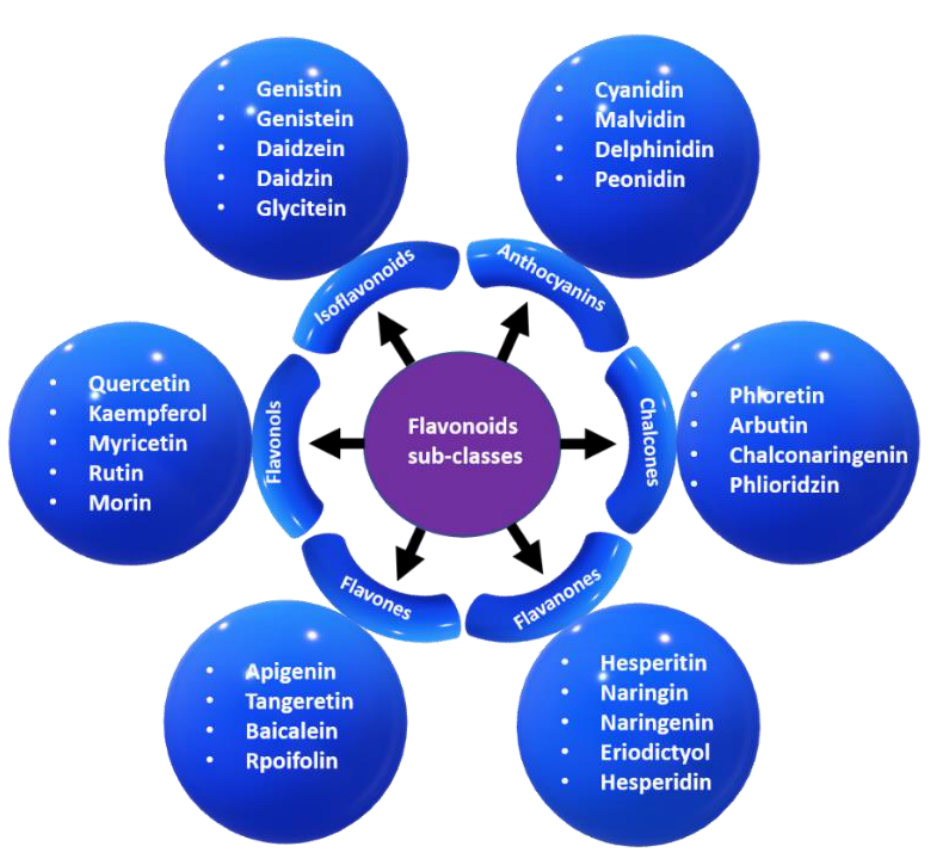
Figure 3. Classification of plant flavonoids.